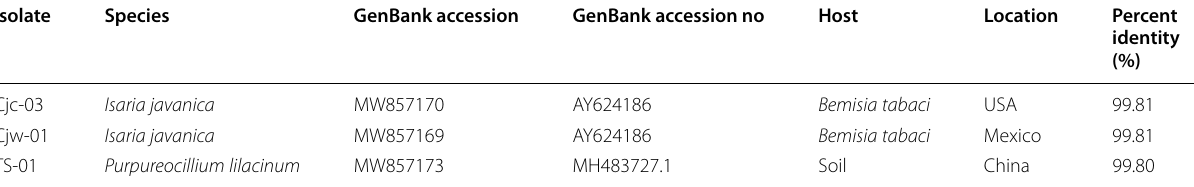
Table 1 GenBank sequences data of entomopathogenic fungi isolated from the whitefly Isolate